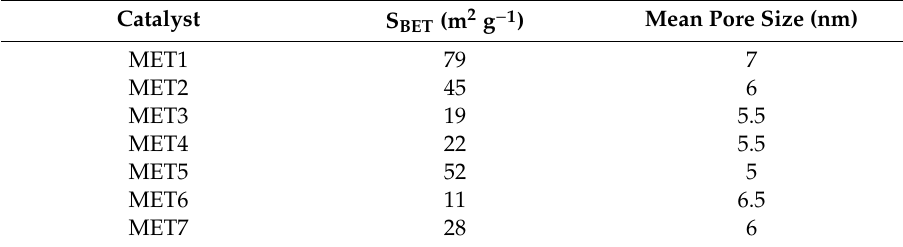
Table 1. Surface area (BET) and pore diameter of all catalyst